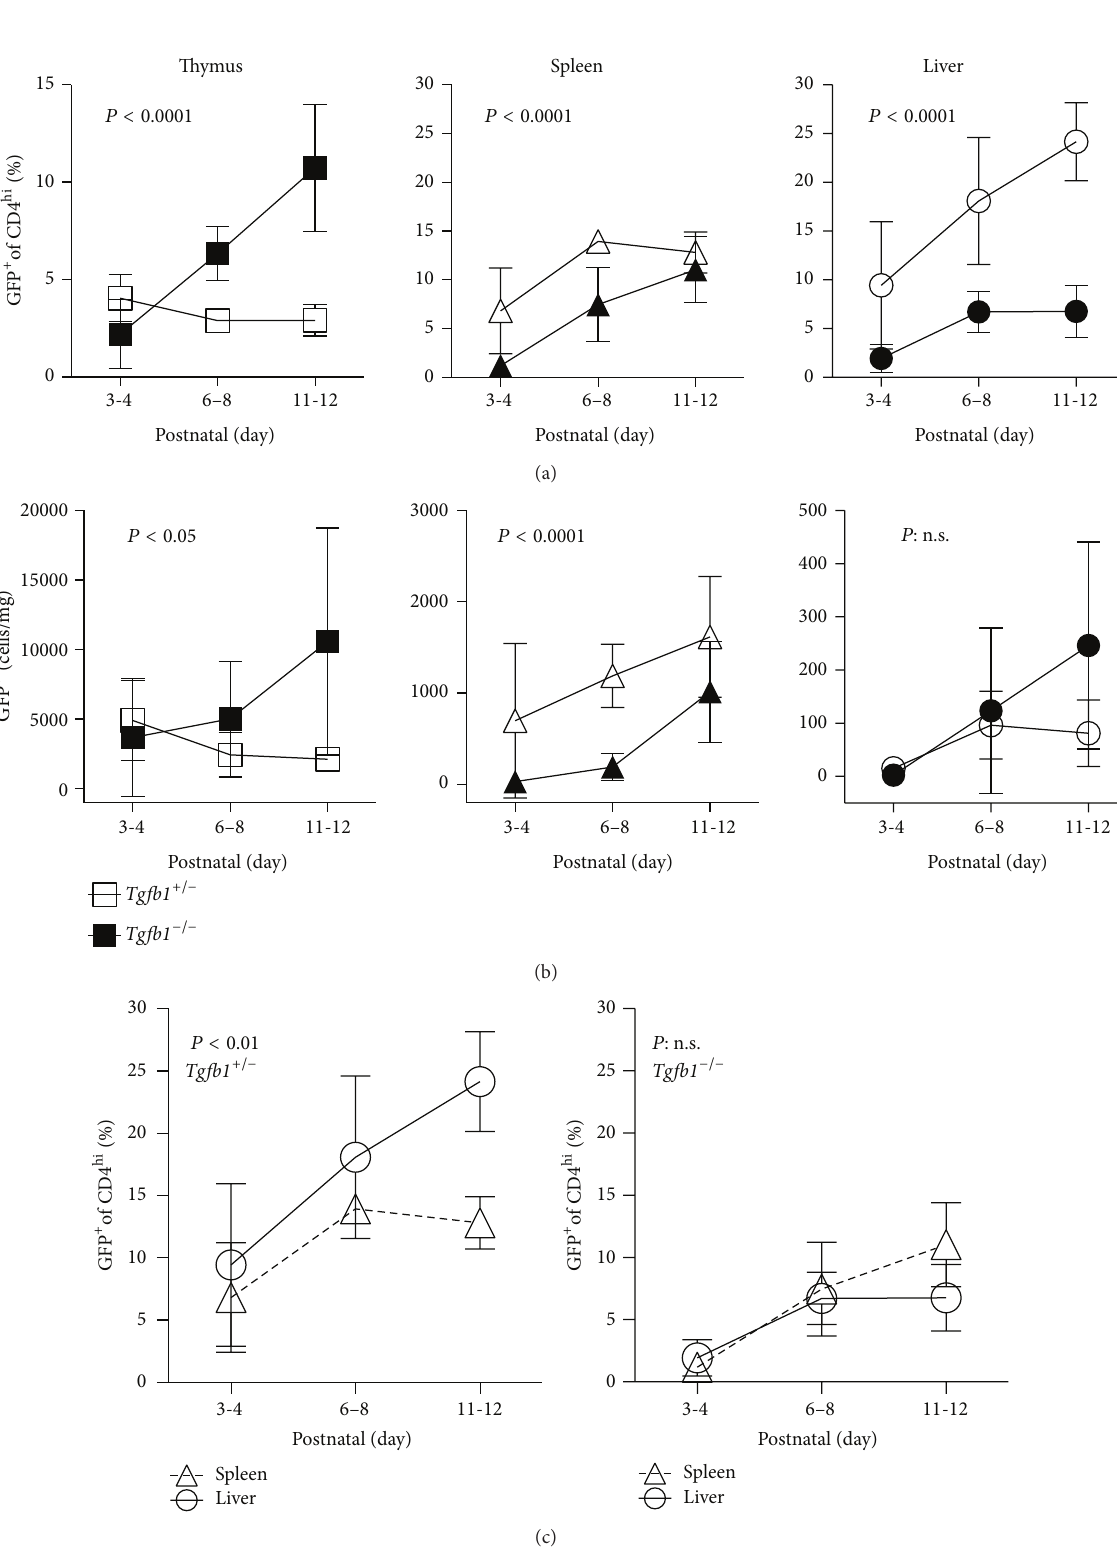
Figure 4: The increased frequency of FoxP3 + CD4 + cells in postnatal liver depends on TGF- 𝛽 1. NPC were isolated from thymus, spleen, and liver of BALB/c-background FoxP 3 EGFP . Tgfb1 +/− mice and littermate FoxP 3 EGFP . Tgfb1 −/− mice at the indicated ages. (a) Frequency data for FoxP3 + CD4 + cells are shown. (b) Density data for FoxP3 + CD4 + cells are shown. (c) Data for spleen and liver are shown for Tgfb1 +/− mice and Tgfb1 −/− mice. 𝑁 = 4 to 9 mice per group at each time point. Statistical analyses were by 2-way